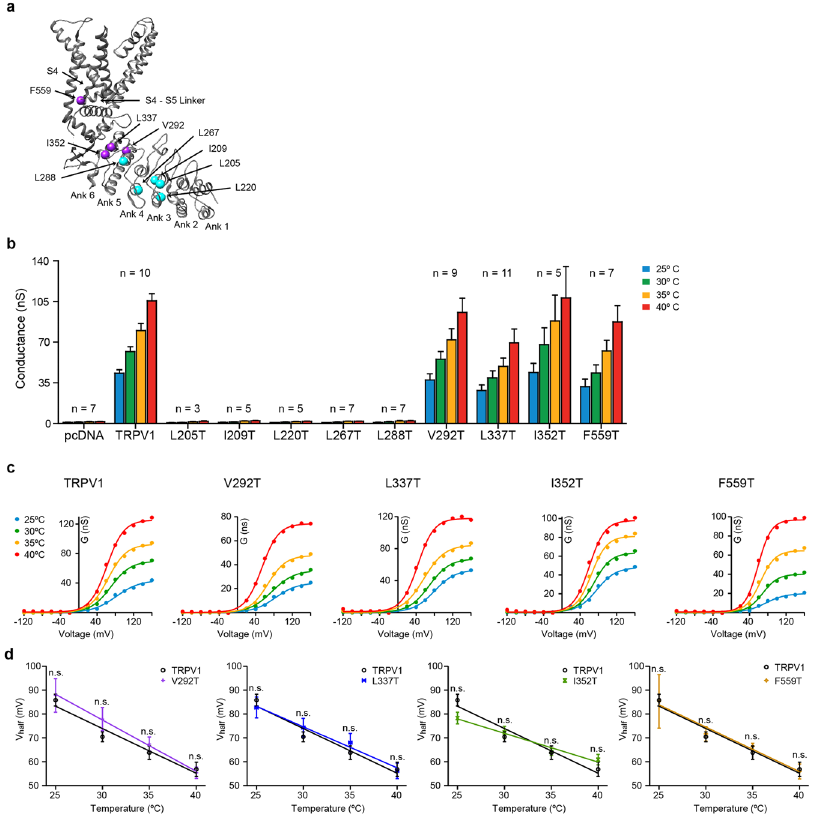
Figure 5. Heat sensitivity of TRPV1 single-point mutants with mutations that neutralized amino acid hydrophobicity. ( a ) Structural location of all the residues mutated in the ankyrin repeats and the beginning of the S4-S5 linker. In cyan are residues that when mutated to Thr, lead to non-functional channels. In purple are residues that, when mutated to Thr, do not affect temperature activation. ( b ) Average conductance at + 160 mV as a function of temperature for mutants. Data represent mean ± SEM. N on top of the bars represent number of individual patches. ( c ) Conductance-voltage (G-V) relationship of plateau current for wild-type TRPV1, V292T, L337T, I352T, and F559T at different temperatures. ( d ) Voltage of half maximal activation (V half ) for wild-type TRPV1, V292T, L337T, I352T, and F559T as a function of temperature. V half was obtained from the fitting parameters of a Boltzmann distribution to the G-V. Data represent mean ± SEM. Lines are linear fits to the data. Wild-type TRPV1 n = 7, V292T n = 9, L337T n = 11, I352T n = 5, and F559T n = 7. Each V half value was tested for statistical significance using an unpaired Student’s t-test. n.s. indicates not significant (p >